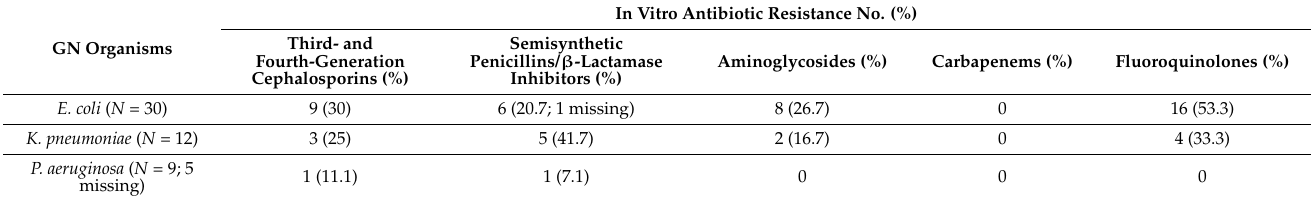
Table 3. In vitro antibiotic resistance in the most frequent Gram-negative (GN) isolates. In Vitro Antibiotic Resistance No.